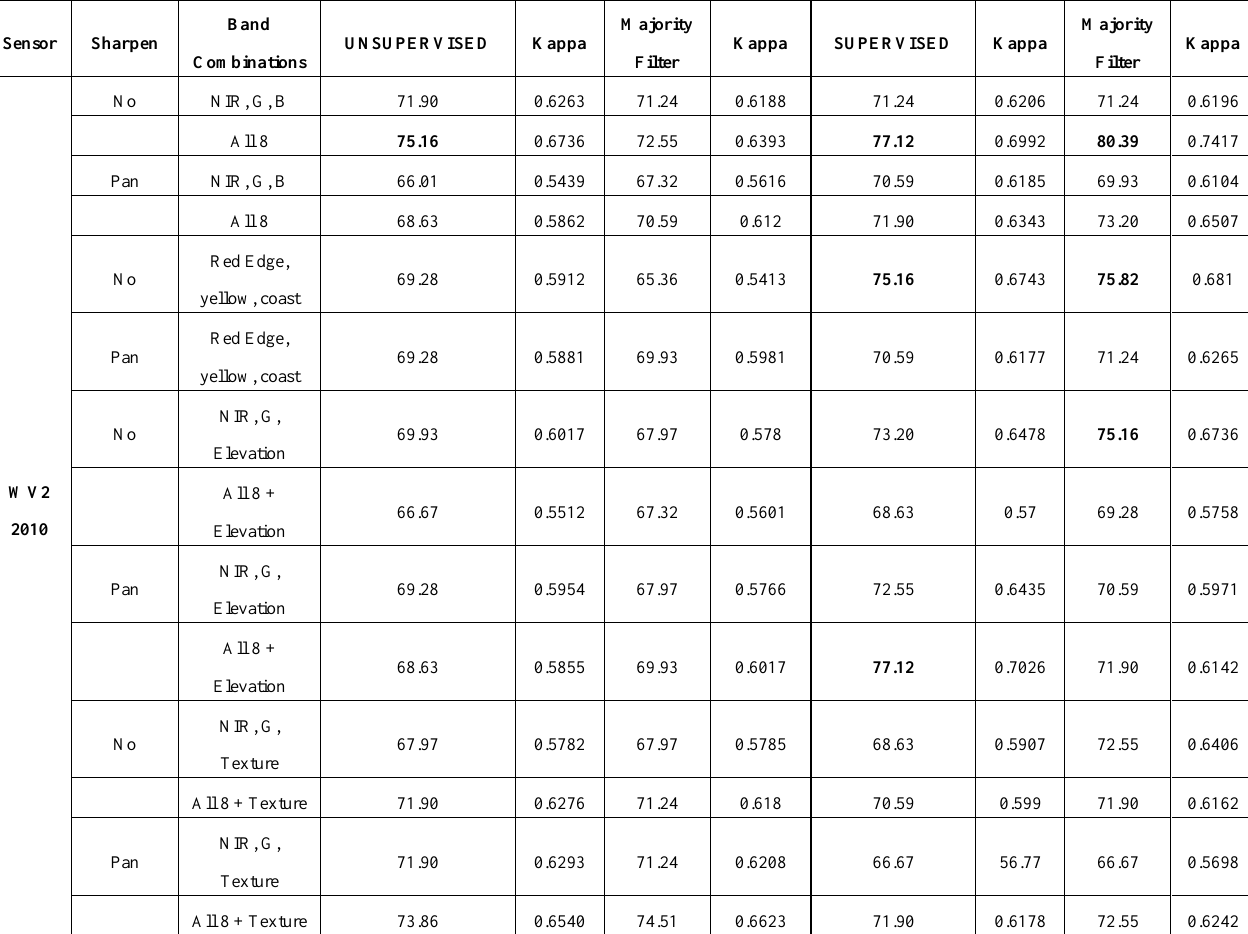
Table 4. Accuracy assessment (in percent correct) and Kappa coefficients for unsupervised and supervised classifications for the Masonboro Island portion of the NERRS study